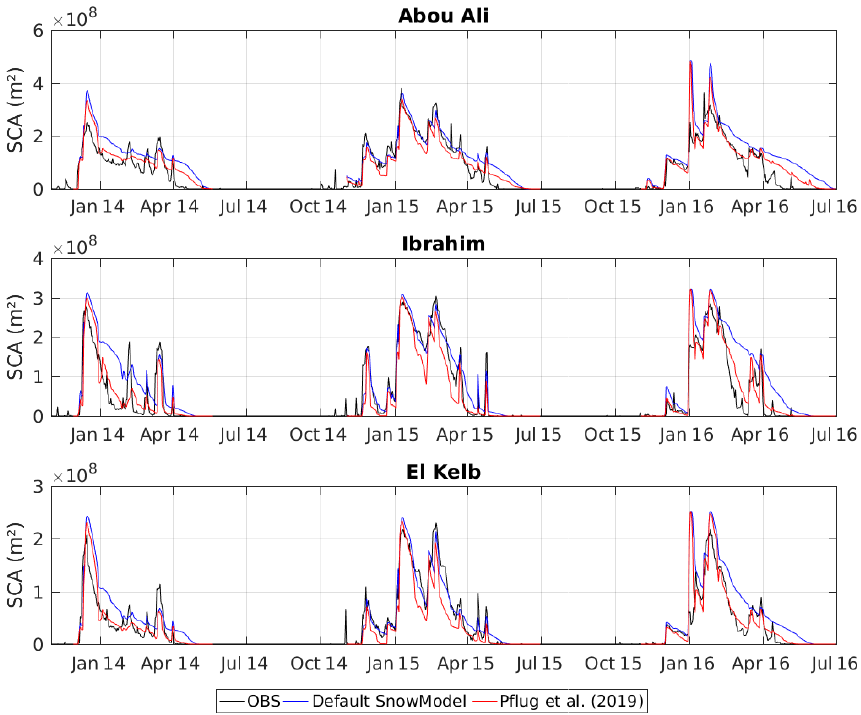
Figure 5. Time series of observed and modeled daily snow cover area in each study catchment. Table 4. Key indicators from the spatially averaged SWE above 1200ma.s.l. (also see Fig. 11): date and value of the peak SWE and melt-out date. Here the Pflug et al. (2019) results are reported. Basin Peak SWE value (mm) Peak SWE date Melt-out date Water year W1314